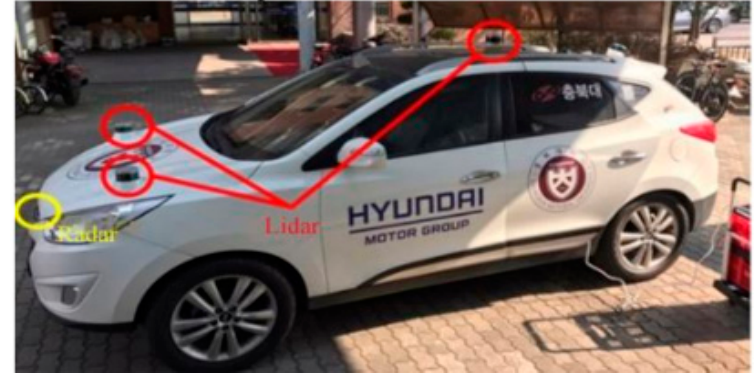
Figure 11. Test vehicle. It was equipped with three lidars and one radar.